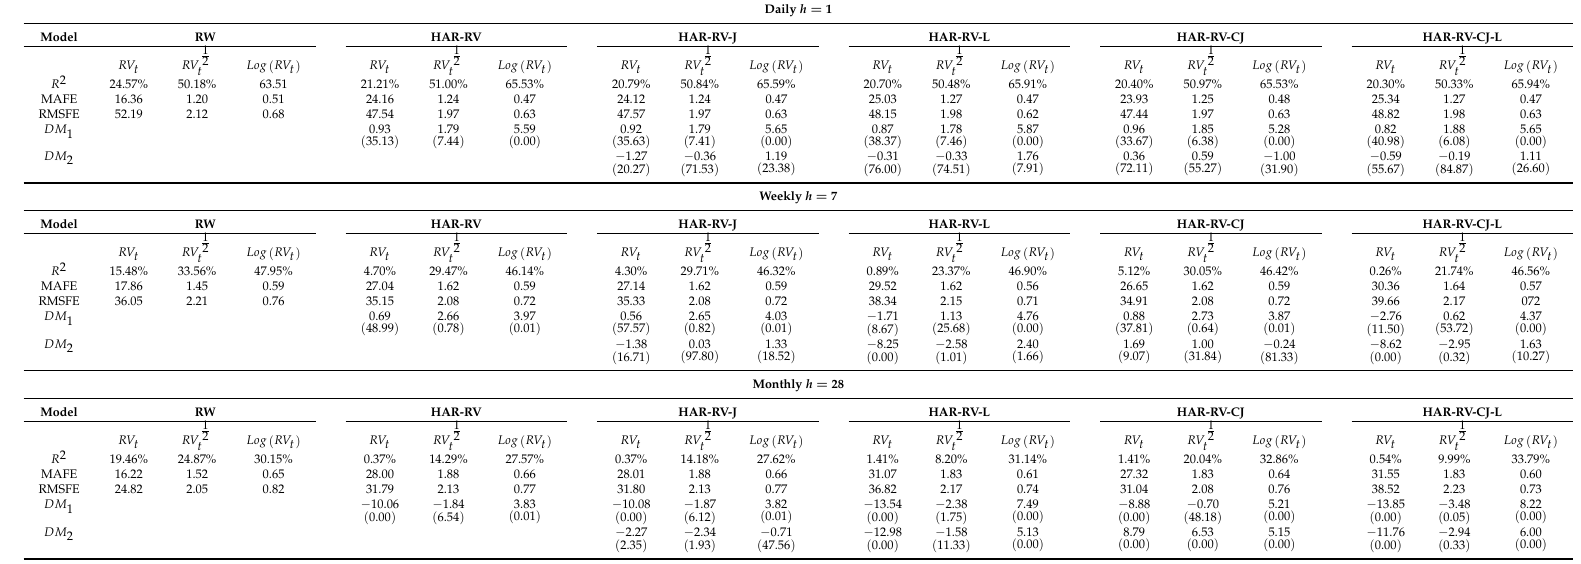
Table 7. This table reports the out of sample forecast results for different HAR models. Results for Bitstamp are reported in panel (A) for Coinbase in panel (B) for the three forecast horizons h = 1, h = 7, and h = 28. Diebold Mariano test statistics with respect to the RW model (DM1) and HAR-RV model (DM2) are reported. p -values based on the asymptotic Gaussian distribution with HAC standard errors are reported in